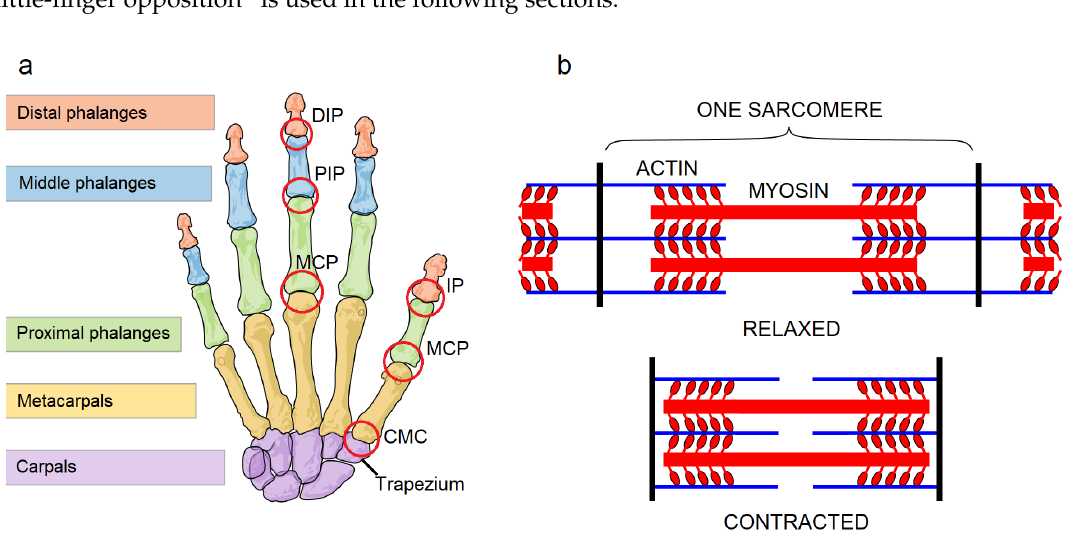
Figure 1. Human-hand principles: ( a ) skeletal system (based on figure by Mariana Ruiz Villarreal); ( b ) muscle-sliding-filament theory (based on figure from